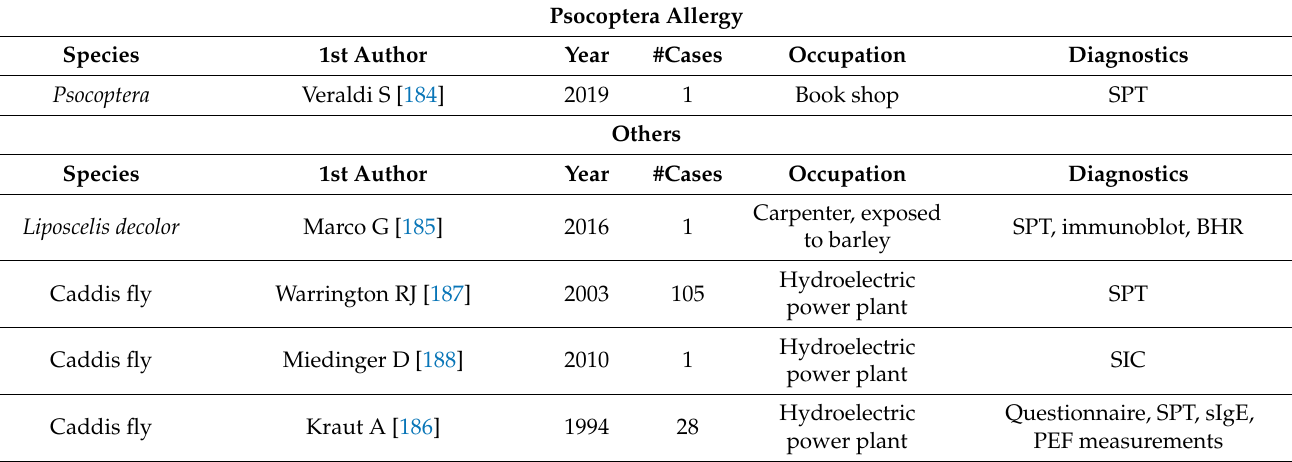
Table 8. Psocoptera allergy and